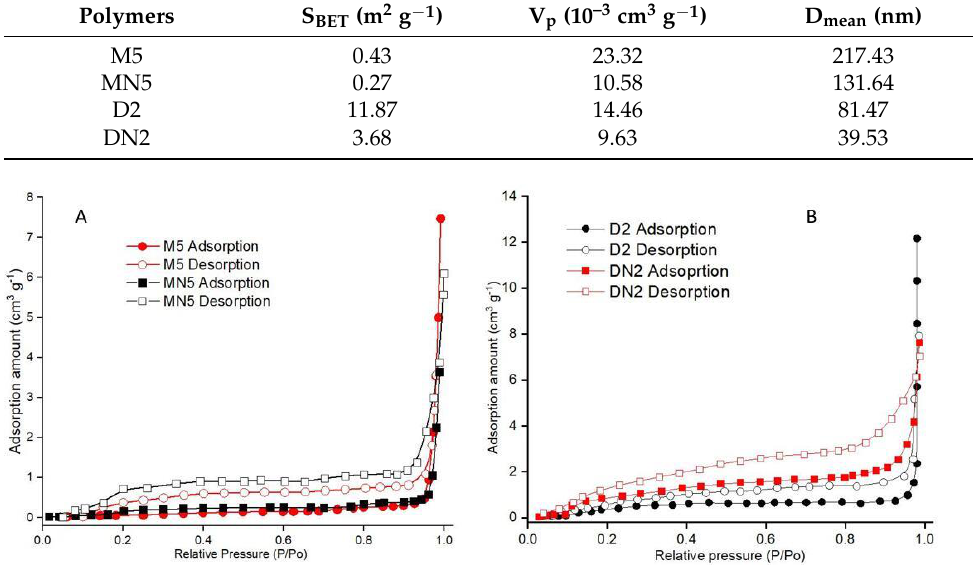
Table 2. The surface area, pore volume, and pore size of the synthesized polymers.